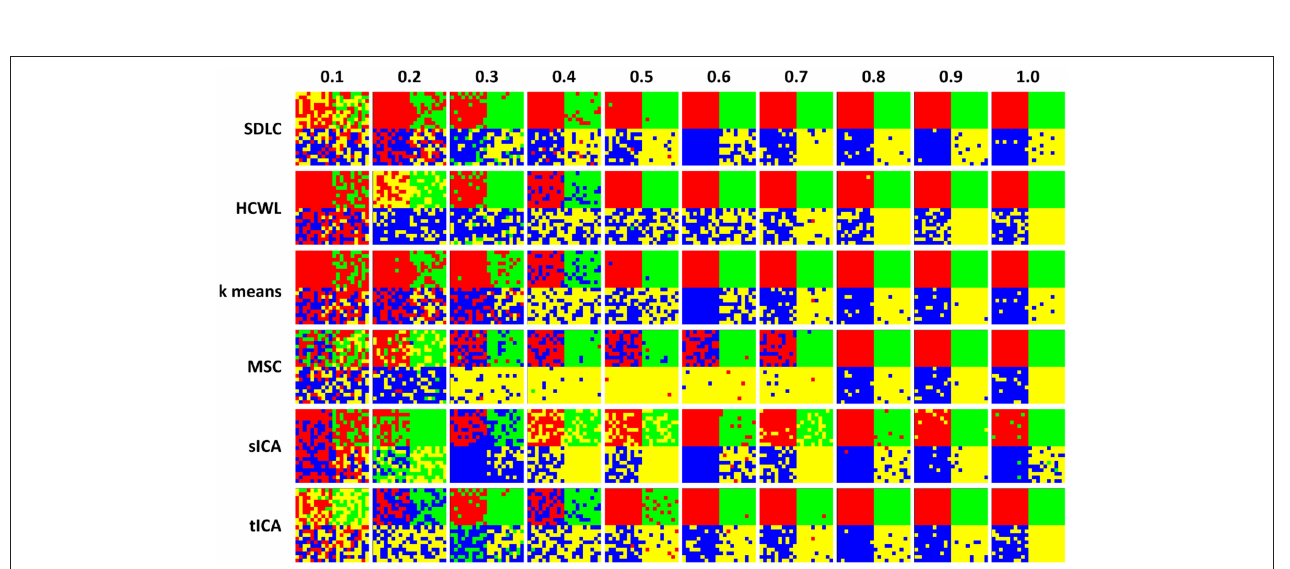
FIGURE 2 | Seven rs-fMRI time courses generated by SimTB for the first simulation.